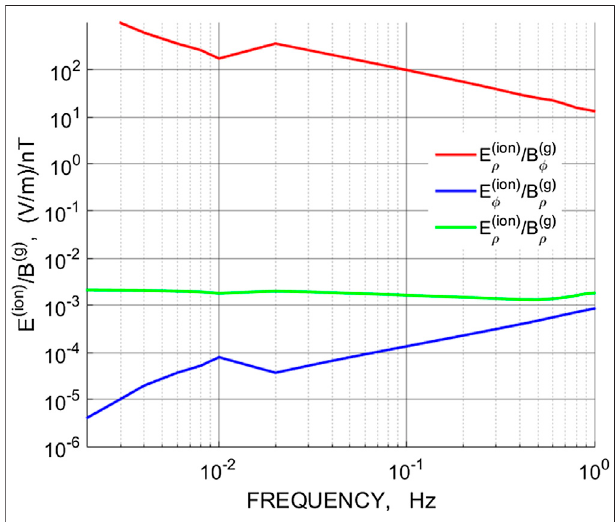
FIGURE 9 | The frequency dependence of the apparent impedances (that is E (f)/ B (f) amplitude ratios) for magnetic and electric